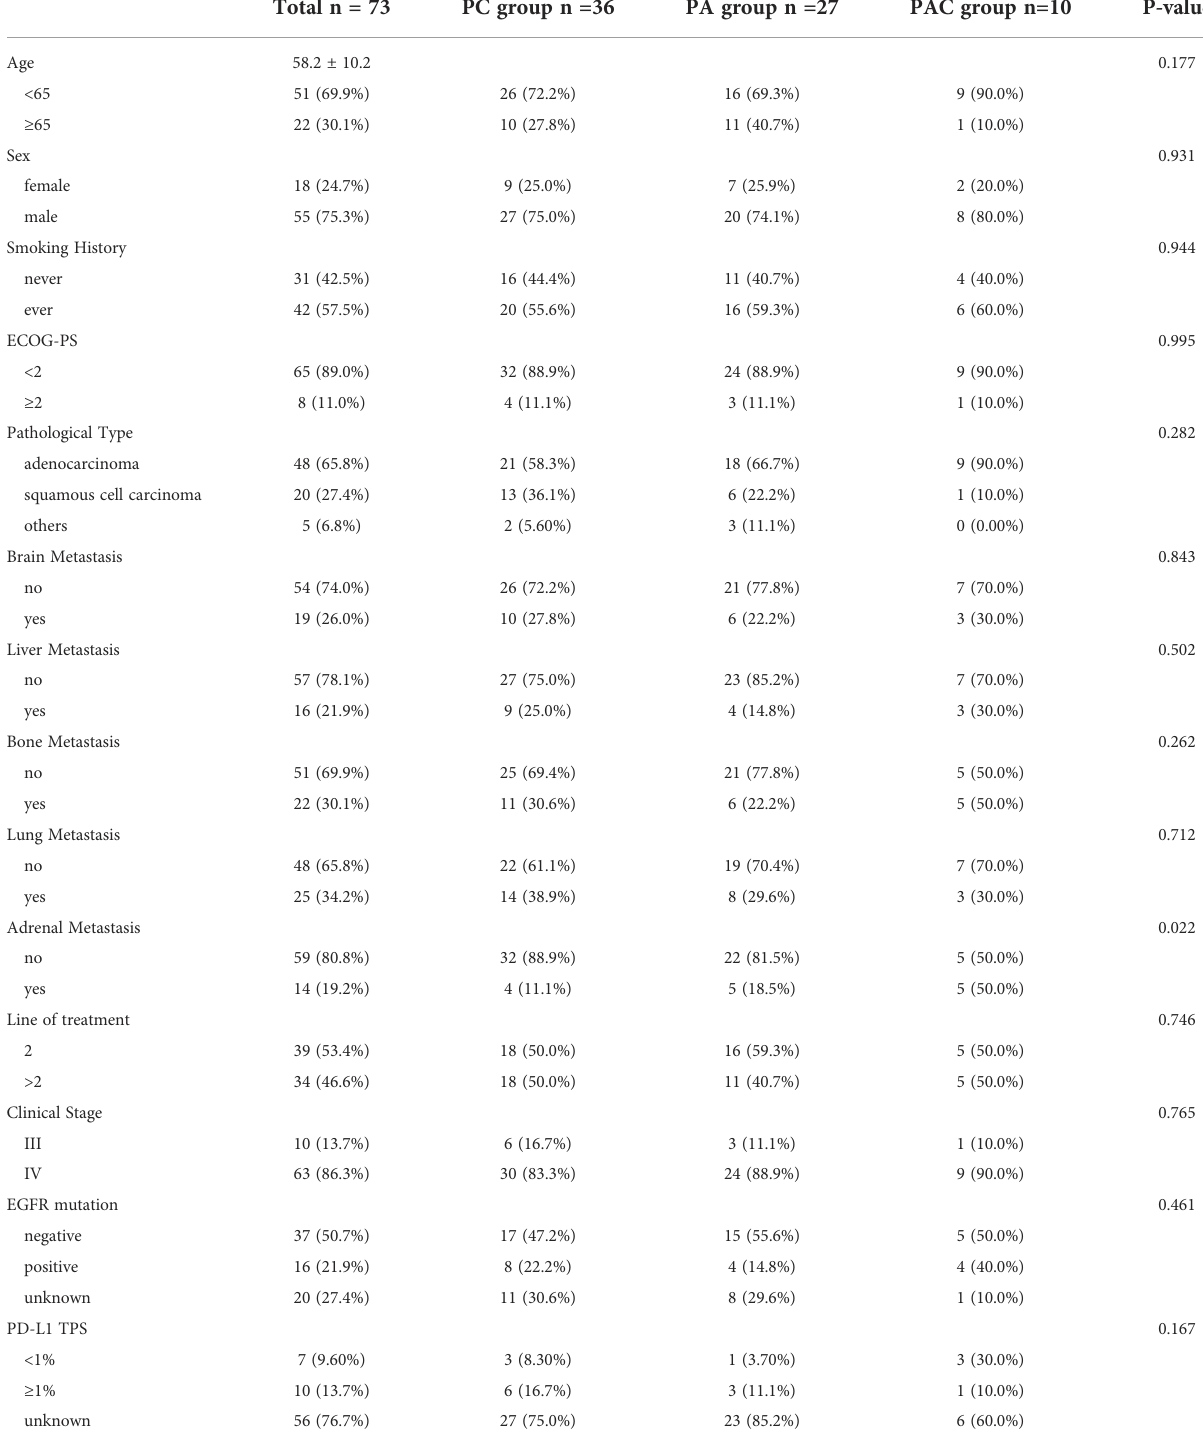
TABLE 1 Baseline clinicopathological